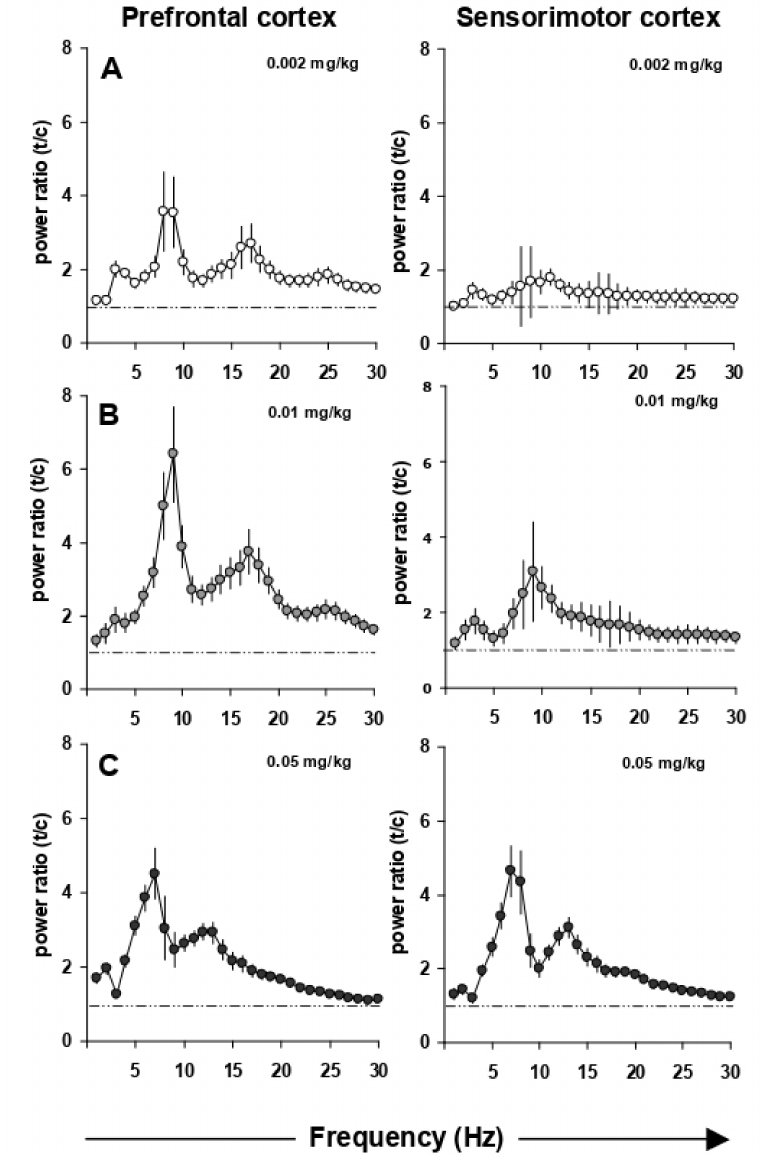
Figure 2. Power spectra (total power) in the prefrontal and sensorimotor cortex with increasing doses of EGIS 11150. Panel ( A ) 0.002 mg/kg EGIS 11150 induces high theta bands (8–10 Hz) in the prefrontal cortex. Panel ( B ) 0.01 mg/kg EGIS 11150 maximally induces high theta bands in the prefrontal cortex. Panel ( C ) 0.05 mg/kg EGIS 11150 maximally induce high theta bands in the sensorimotor cortex ( n =